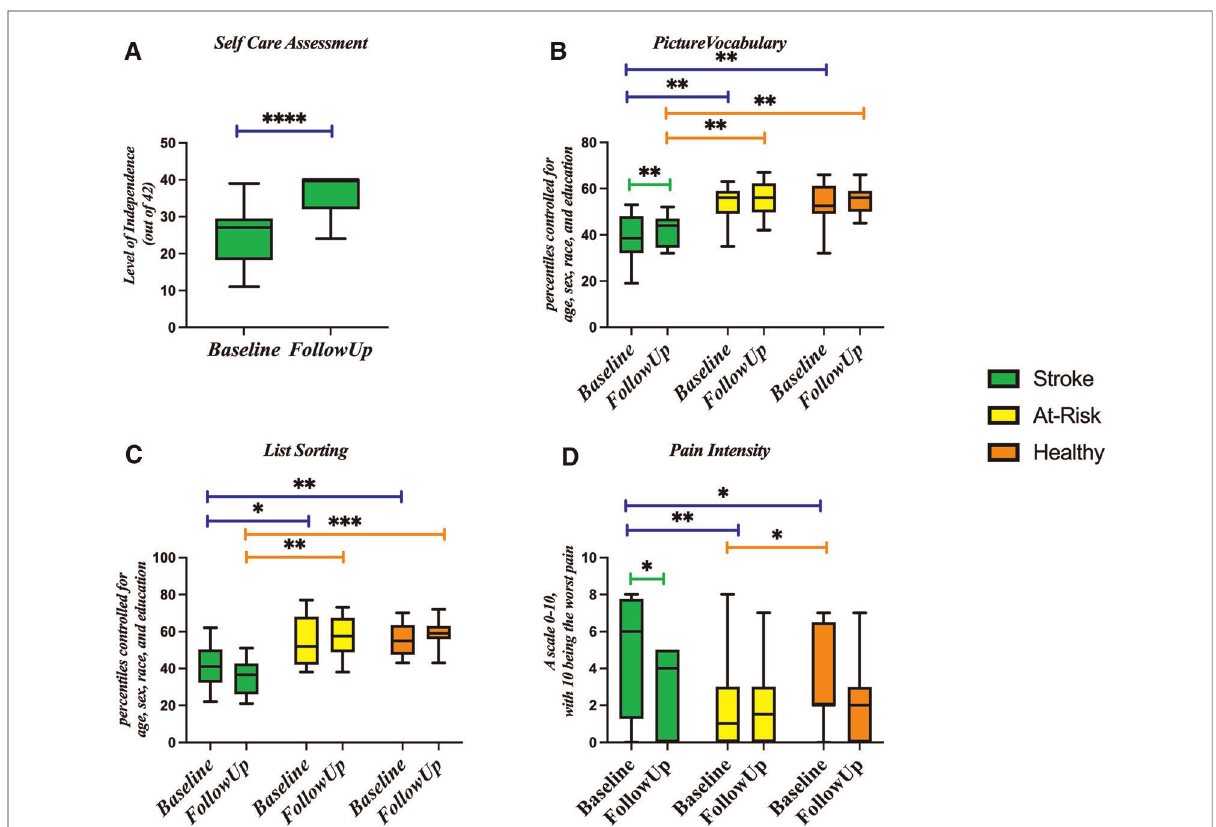
FIGURE 6 Markers of stroke function at baseline and follow up for stroke, at-risk, and healthy participants. Assessments include ( A ) self-care assessment, ( B ) picture vocabulary, ( C ) list sorting, and ( D ) pain intensity. * p -value<0.05; ** p -value<0.01; *** p